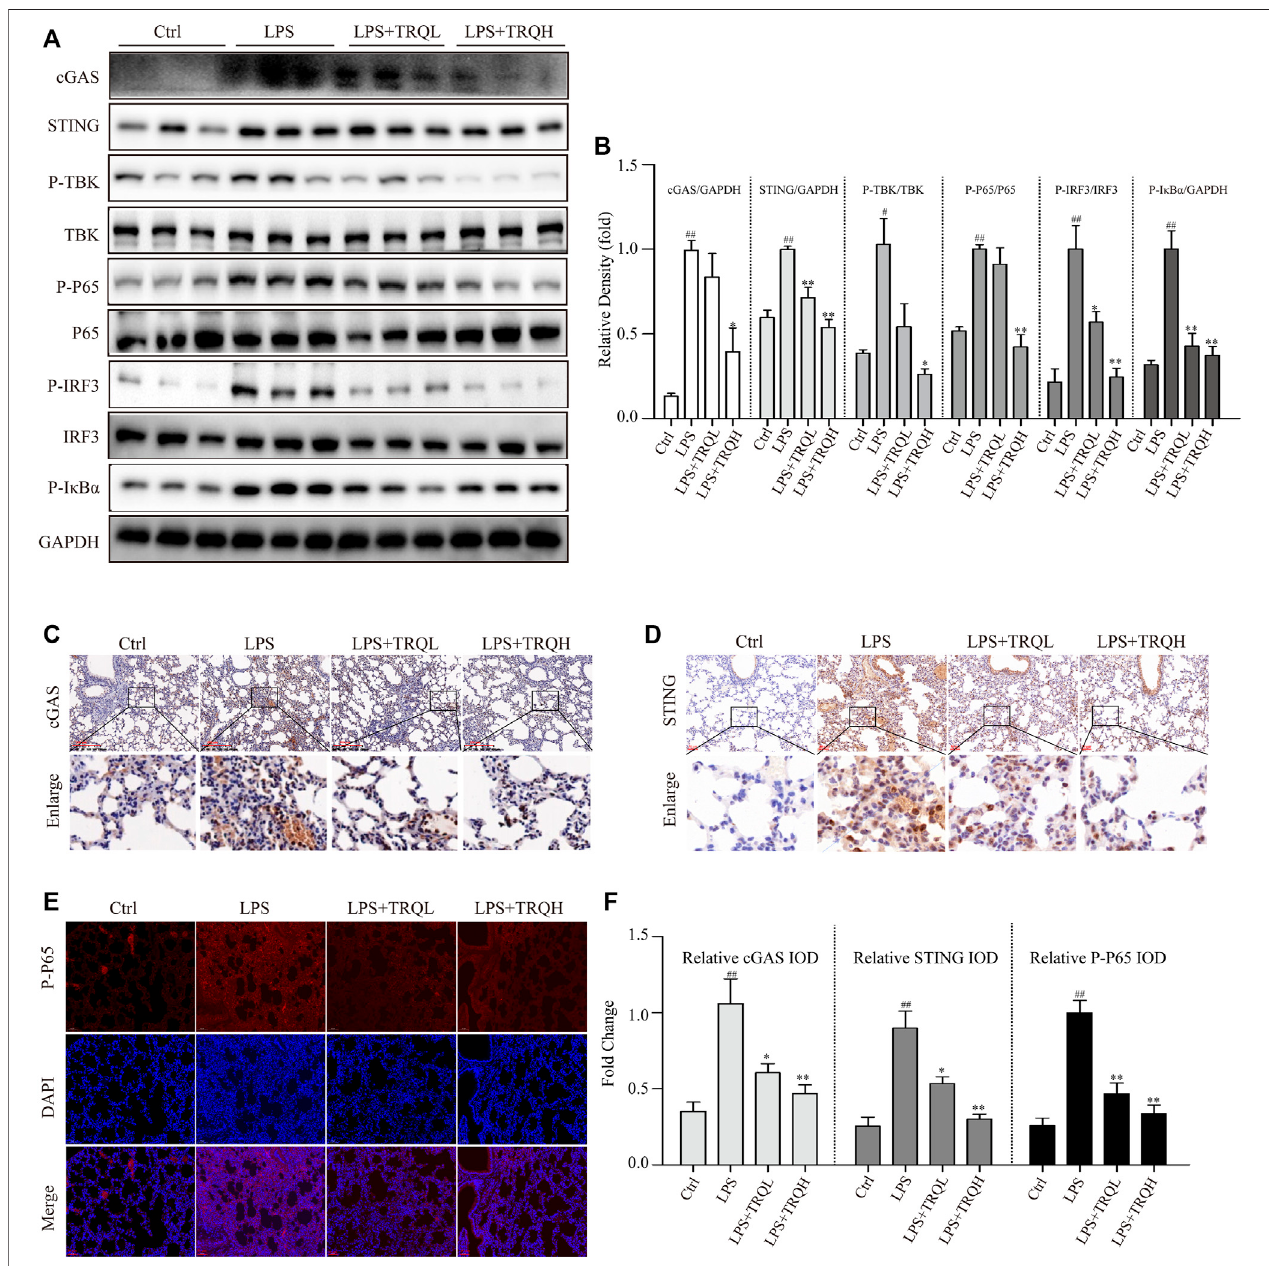
FIGURE 6 | TRQ suppressed STING-mediated IRF3/NF- κ B signaling pathways in LPS-induced ALI mice. (A – B) The representative images and quantitative analysis of cGAS, STING, P-TBK, TBK, P-P65, P65, P-IRF3, IRF3, and P-I κ B α in lung tissues. n (cid:2) 3. (C – F) Representative images and quantitative analysis of cGAS, STING, and P-P65 in lung tissues. n (cid:2) 5. ## p < 0.01 vs. Ctrl group; *p < 0.05 and ** p < 0.01 vs. LPS group, respectively.